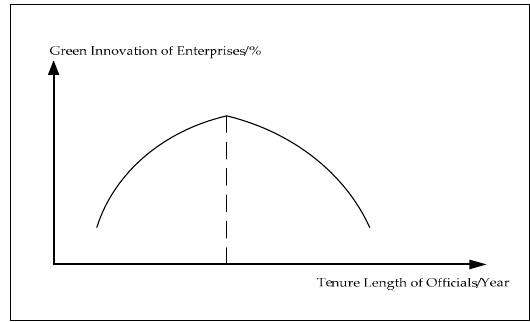
Figure 1. The relationship between the tenure length of officials and enterprise green innovation. Hypothesis 2: There is an inverted U-shaped relationship between the tenure length of o ffi cials and the level of enterprise green innovation in their regions